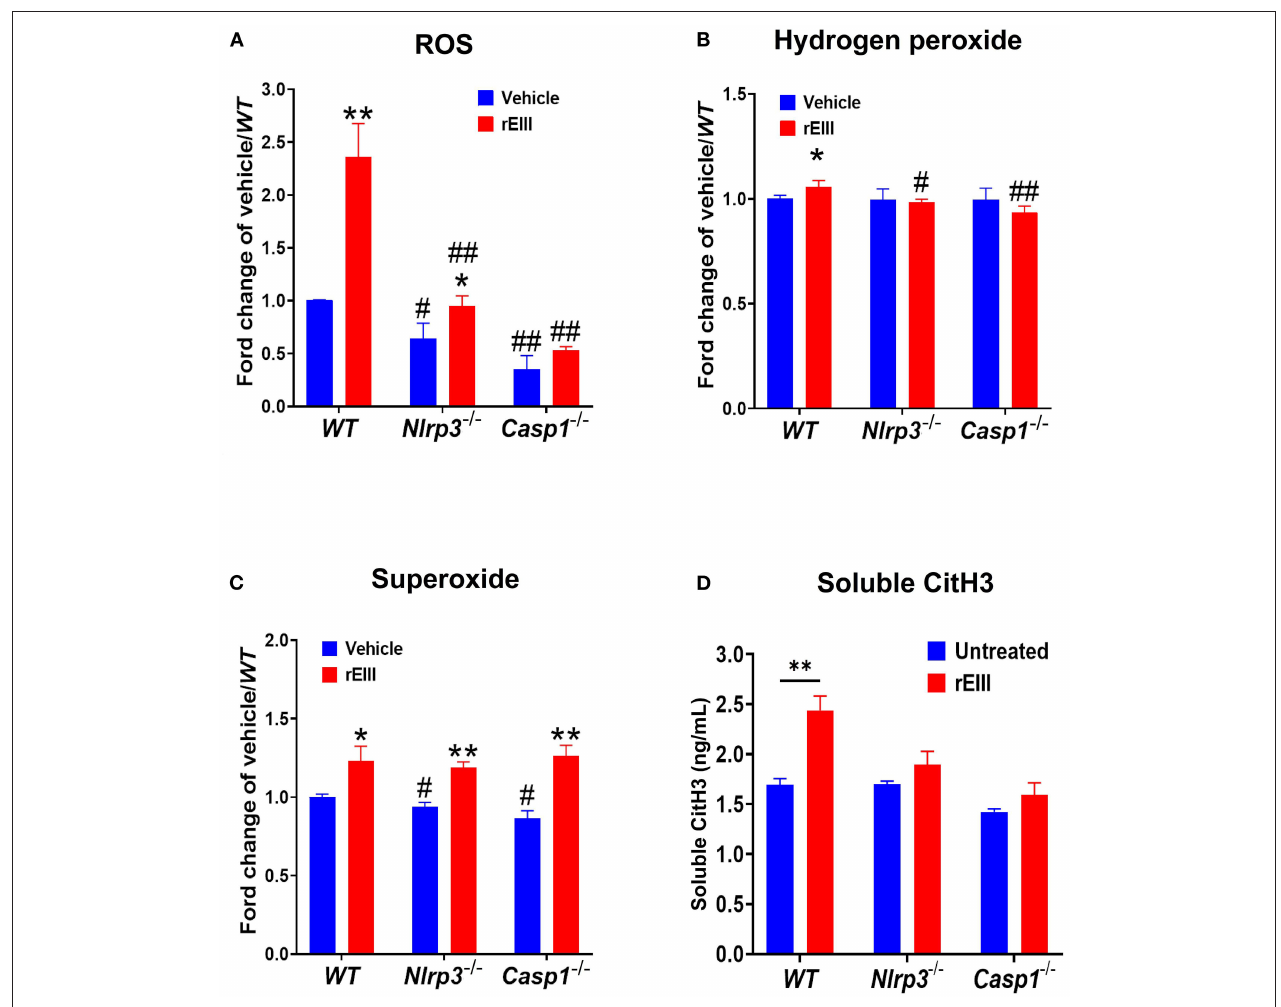
FIGURE 7 | Nlrp3 and caspase 1 deficiencies protest rEIII-induced neutrophil ROS production and NETosis. Treatments (1h) of rEIII (0.6 µ M)-induced elevations of neutrophil cellular reactive oxygen species (ROS) (A) hydrogen peroxide (B) , superoxide (C) in vitro . Treatments (1 d) of rEIII (2 mg/kg)-induced elevations of circulating CitH3 (D) levels in wild type mice. By contrast, such rEIII (0.6 µ M in vitro , 2 mg/kg in mice)-induced stimulations are markedly reduced in Nlrp3 − / − and Casp1 − / − gene knockout mice in both in vitro and in vivo experiments (A–D) . n = 6, # P < 0.05, ## P < 0.01, vs. respective wild type (WT) groups; * P < 0.05, ** P < 0.01, vs. respective vehicle